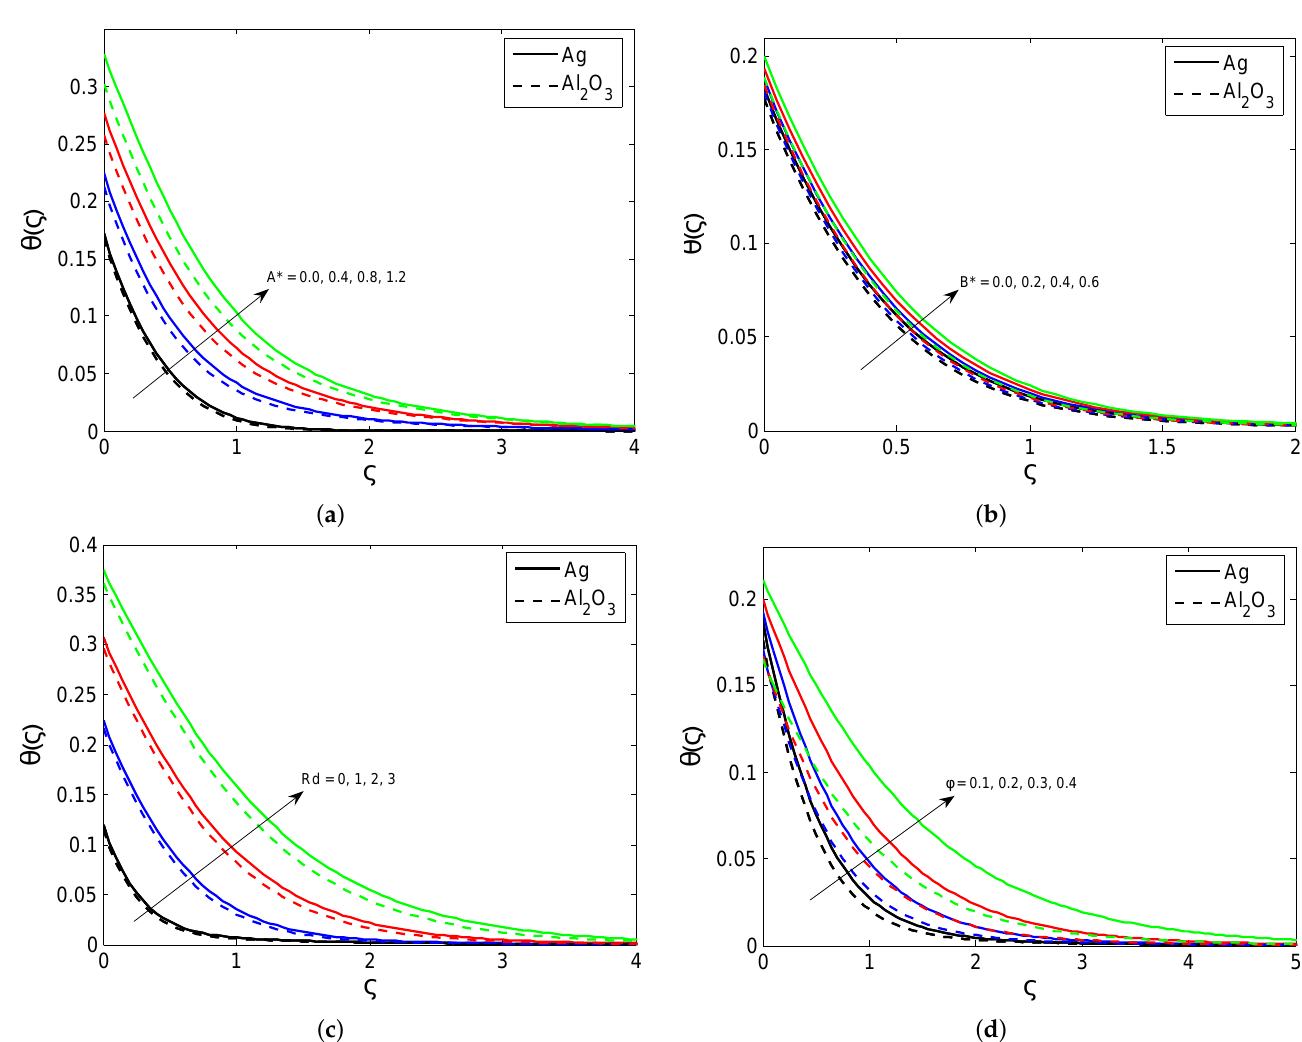
Figure 4. The variation of θ ( ς ) in relation to ( a ) A ∗ , ( b ) B ∗ , ( c ) Rd and ( d ) φ